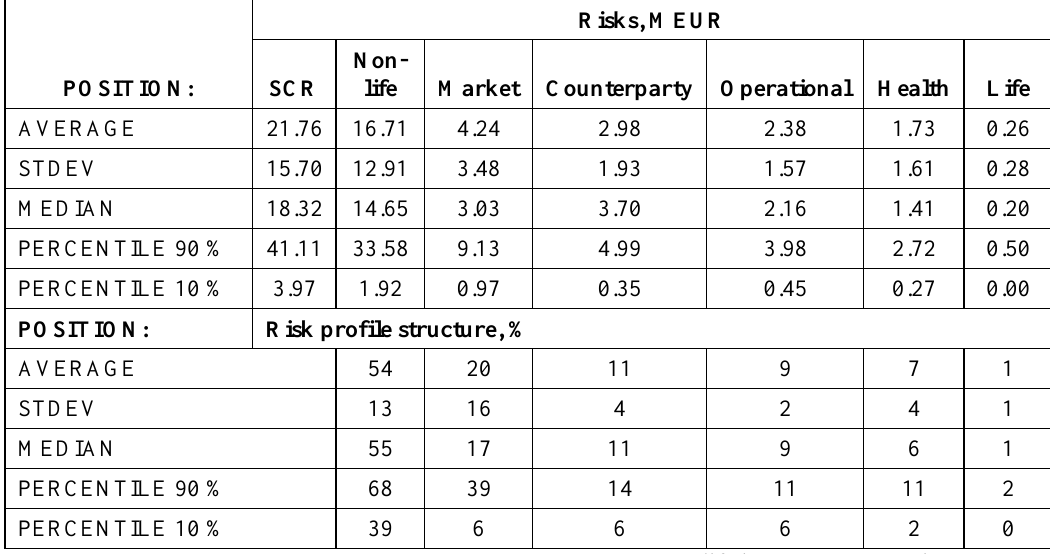
Table 5. Risks and profile